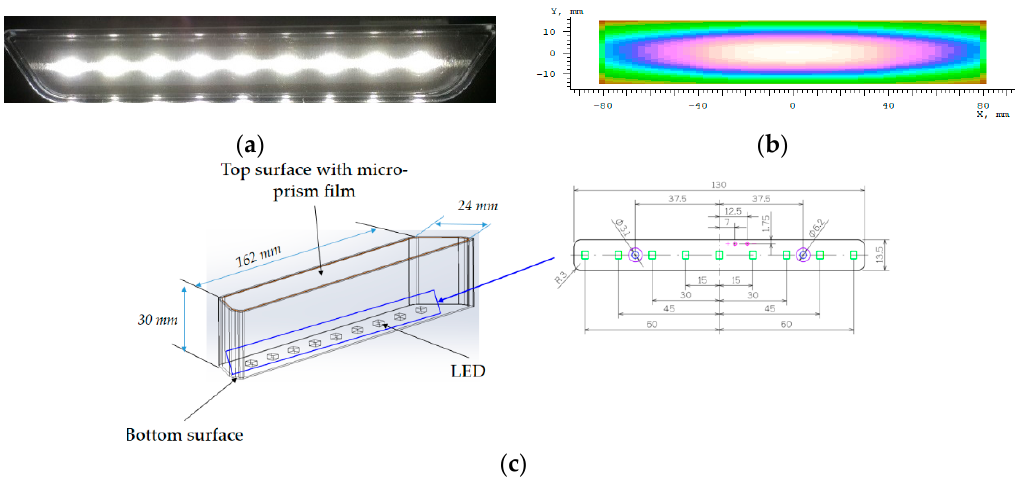
Figure 6. ( a ) The conventional rear position lamp sample; ( b ) the simulated illumination distribution of the conventional rear position lamp; ( c ) the design drawing of the proposed rear position lamps.